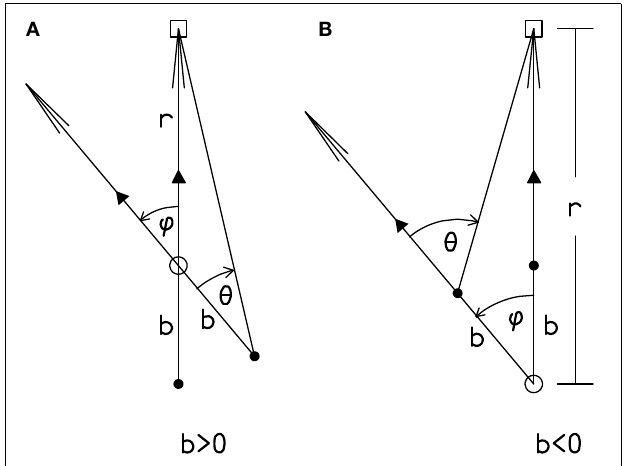
FIGURE A1 | The source of sound, indicated by the square, is fixed in space. The head is shown in two orientations, defined by the arrows indicating the forward directions. Consistent with the definition of the forward direction, the arrow passes through the nose (triangle) and the COH (black dot). Because of the colinear assumption, it also passes through the axis of rotation shown by the open circle. In case (A) the center of the head is behind the axis of rotation so that b and ρ are positive. In case (B) the center of the head is in front of the axis of rotation so that b and ρ are negative. Equation (1) and the three steps apply to both cases. The directed arcs show the positive directions for θ and φ .